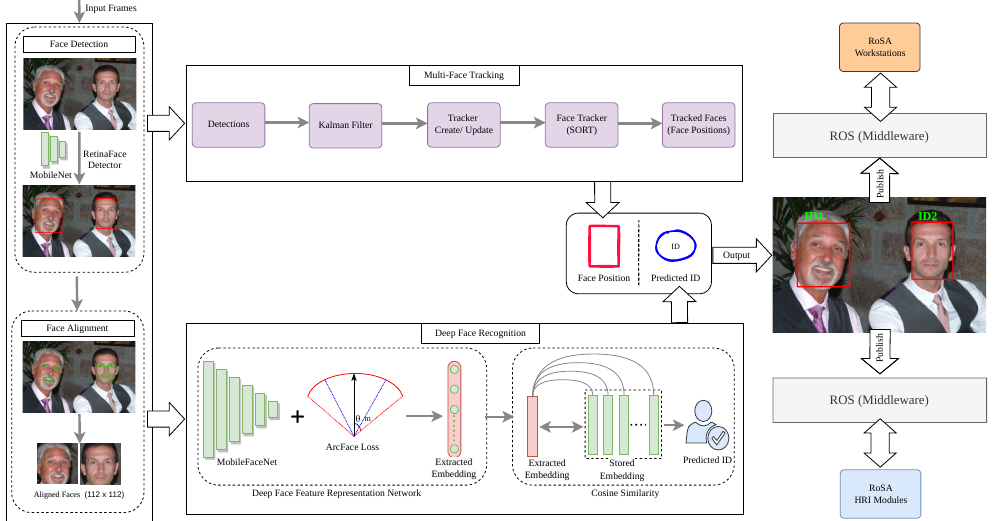
Figure 4. An overview of the proposed face recognition and tracking framework. The predicting face locations and identities are published to the ROS network for broadcasting to RoSA workstations and